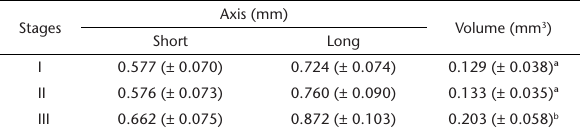
Table 5. Axes lengths and volumes of three stages of Palaemon pandaliformis eggs. Mean (± SD). Values with different letters are significantly different (p < 0.05).